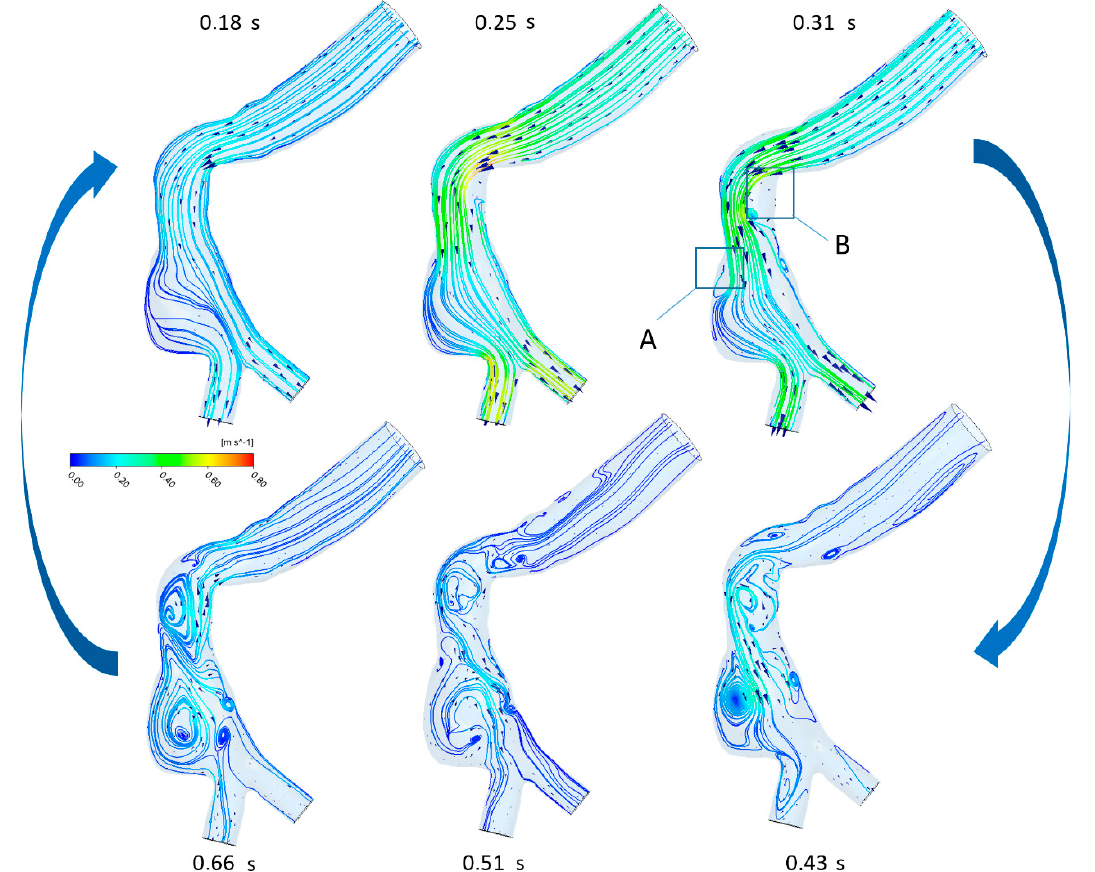
Figure 5. 2D streamlines on the longitudinal cross-section of the patient-specific model of the rupturing aneurysm at the selected instants of the cardiac cycle. In the figure, the recirculation areas in the aneurysm and the healthy aorta are indicated respectively with the letters A and B.